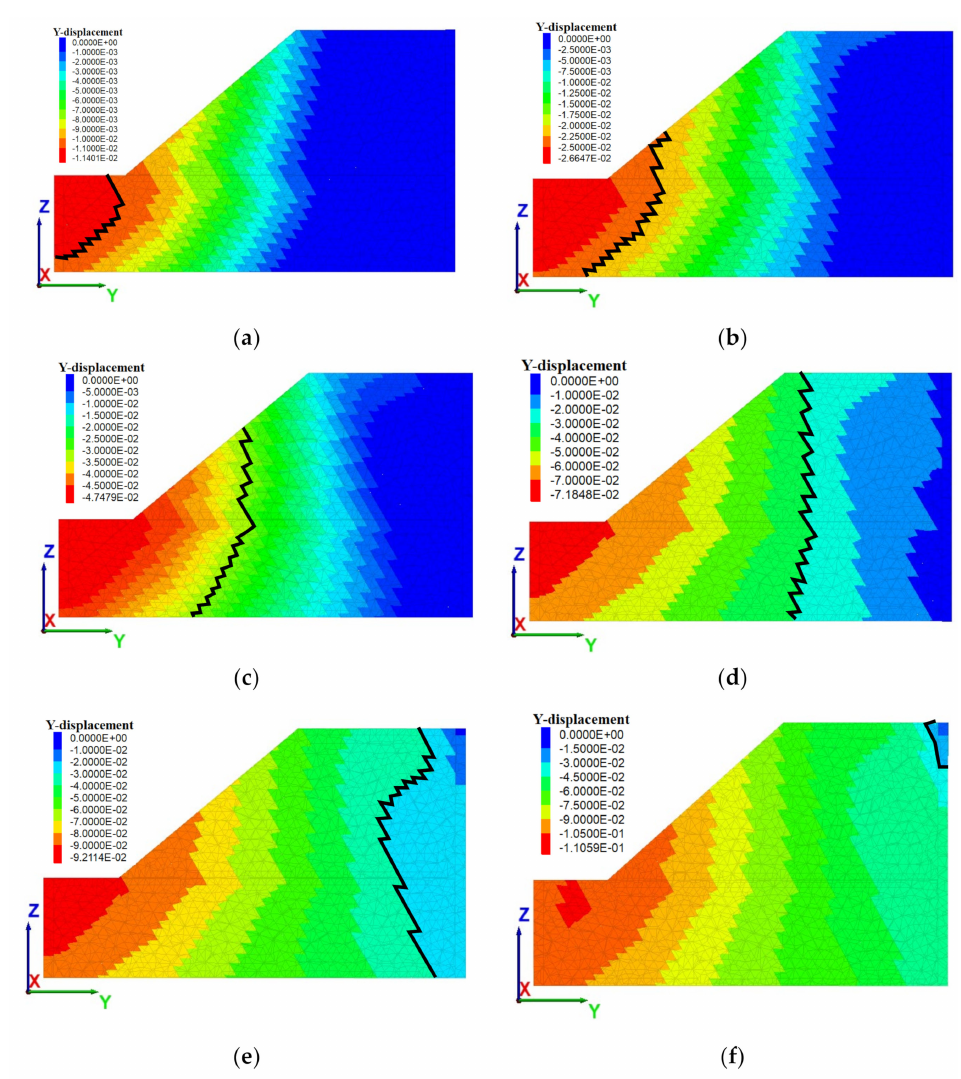
Figure 11. Contour plots of the displacement in the Y -direction of a slope ( α = 40 ◦ and β = 60 ◦ ) subjected to a natural seismic wave. The plots show the displacements in the plane corresponding to x = 10 m at different times after the onset of the seismic disturbance: ( a ) 1 s, ( b ) 2 s, ( c ) 3 s, ( d ) 4 s, ( e ) 5 s, and ( f ) 6